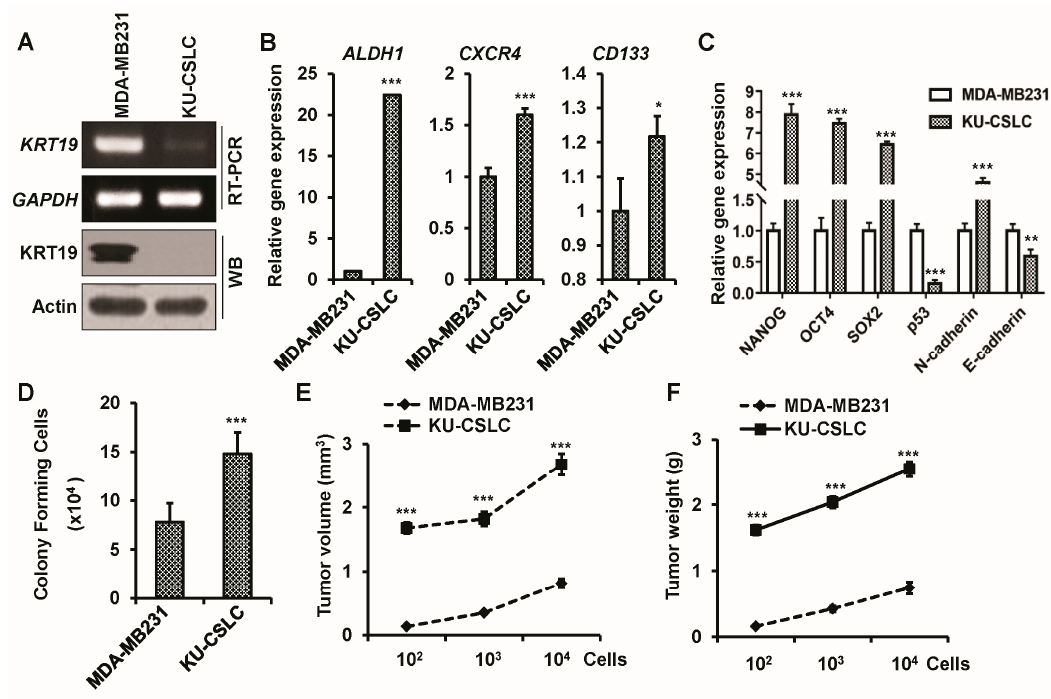
Figure 2. Patient-derived cancer stem-like cells (konkuk university-cancer stem cell-like cell (KU-CSLCs)) show downregulated KRT19 expression and highly aggressive cancer stem cell-like cells (CSLC) properties. ( A ) mRNA and protein expression levels of KRT19 were analyzed using RT-PCR and western blot (WB) in MDA-MB231 and KU-CSLC cells; ( B ) mRNA expression levels of ALDH1 , CXCR4 , and CD133 were analyzed using real-time polymerase chain reaction (qRT-PCR) in MDA-MB231 and KU-CSLC cells. The specific band intensity was measured by the scanning densitometry program in ImageJ and normalized to that of a housekeeping gene, GAPDH . * p < 0.05; *** p < 0.001; ( C ) mRNA expression levels of stemness ( NANOG, OCT4 , and SOX2 ), epithelial-to-mesenchymal (EMT; N- and E-cadherin ) markers, and P53 were analyzed using qRT-PCR in MDA-MB231 and KU-CSLC cells. ** p < 0.01; *** p < 0.001; ( D ) Colony formation assay was analyzed in serum-free media (SFM) using non-coated plates. After five days of culture, colonies from either KU-CSLCs or MDA-MB-231 cells were collected and stained with crystal violet. The stained colonies were enumerated and presented as colony forming cells ( × 10 4 ). *** p < 0.001; ( E , F ) An indicated number of MDA-MB231 or KU-CSLC cells were injected into SCID mice ( n = 5) and after four weeks of post tumor formation, the mice were excised. Tumor volume (mm 3 ) and weight (g) were assessed after the biopsy. *** p < 0.001.